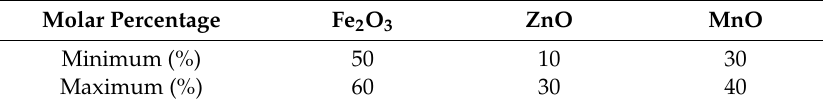
Table 2. Material molar composition percentage of MnZn soft ferrites.